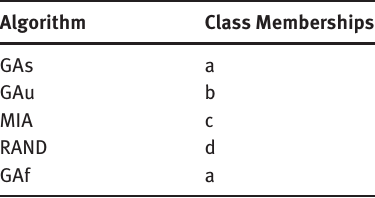
Table 8. Length 51 32 PSK: Tukey HSD Class Memberships.